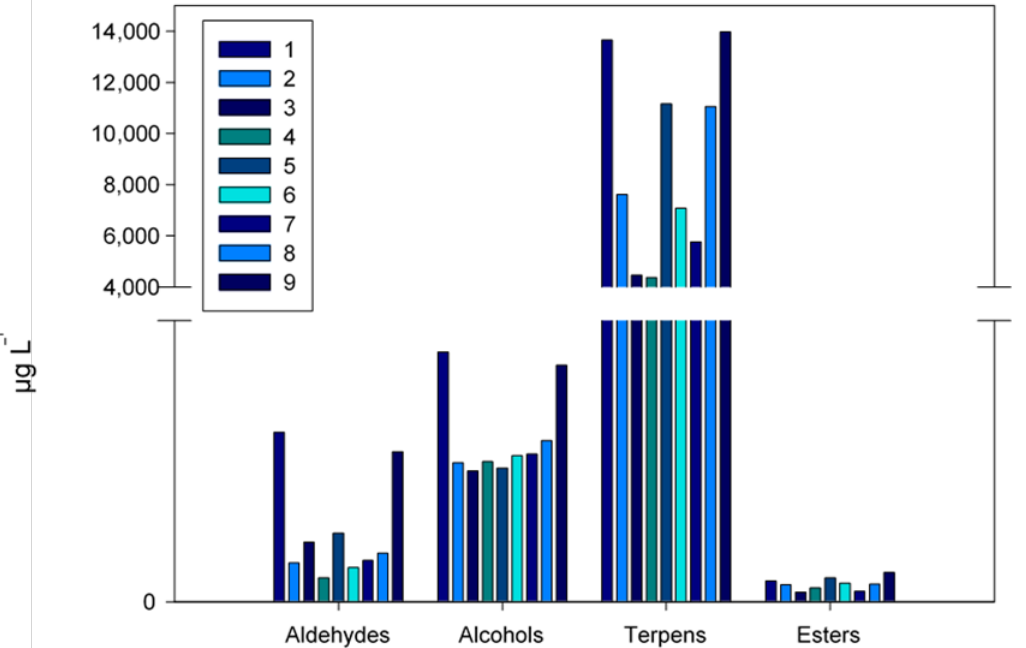
Figure 1. Concentration ( µ g L − 1 ) of the main chemical families identified in mandarins ( Citrus clementina Hort. ex Tan.). Rootstock: “Carrizo citrange” (1), “Swingle citrumelo CPB 4475” (2), “Macrophylla” (3), “Volkameriana” (4), “Forner-Alcaide 5” (5), “Forner-Alcaide V17” (6), “C-35” (7), “Forner-Alcaide 418” (8), and “Forner-Alcaide 517” (9). Table 4. Statistical differences found between the different chemical families. Ϯ *** significant at p < 0.001. ‡ Values followed by the same letter, within the same chemical family were not significantly different ( p < 0.05), according to Tukey’s least significant difference test. Rootstock: “Carrizo citrange” (1), “Swingle citrumelo CPB 4475” (2), “Macrophylla” (3), “Volkameriana” (4), “Forner- Alcaide 5” (5), “Forner-Alcaide V17” (6), “C-35” (7), “Forner-Alcaide 418” (8), and “Forner-Alcaide 517” (9).